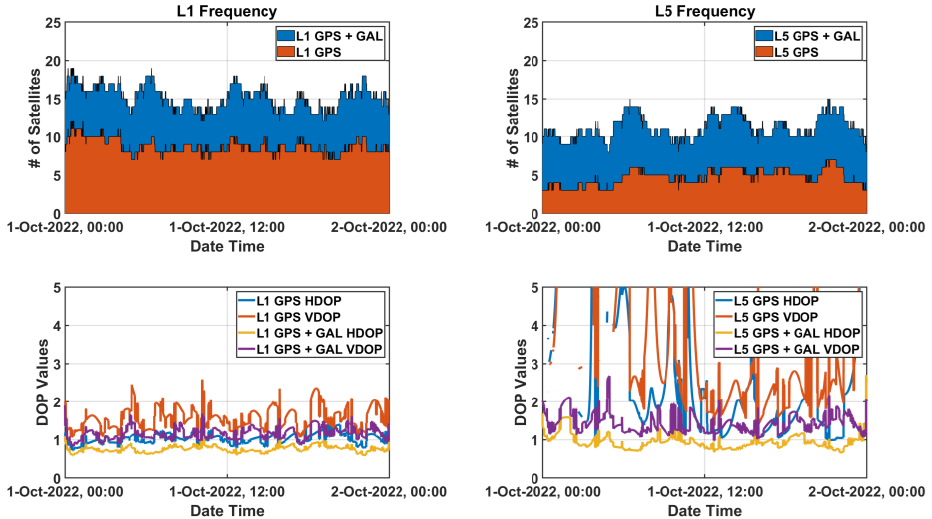
Figure 8. Available satellites status observed at SOUL reference station, Korea on 1 October